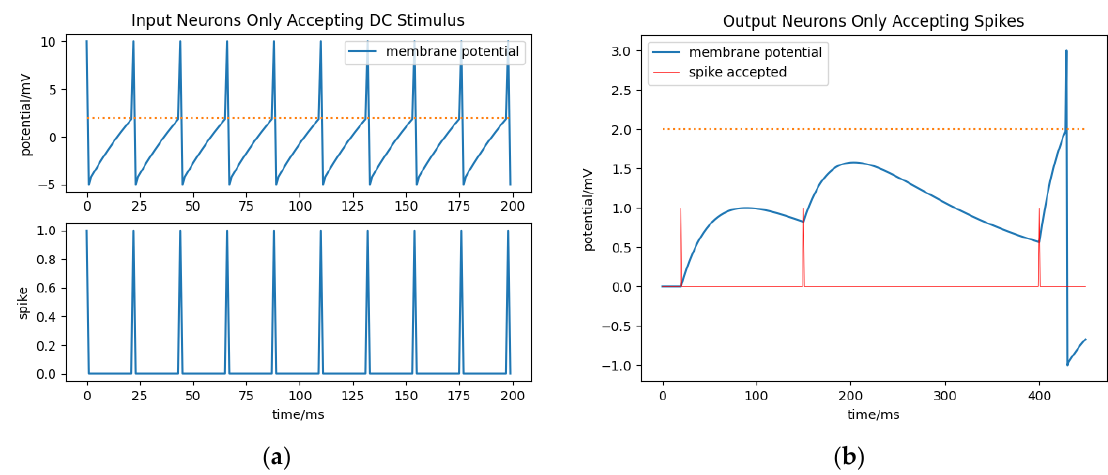
Figure 2. The membrane potential changes with time: ( a ) The membrane potential and firing spikes of input neurons which only accept DC stimulus; ( b ) The membrane potential and firing spike of output neurons that only accept spikes.